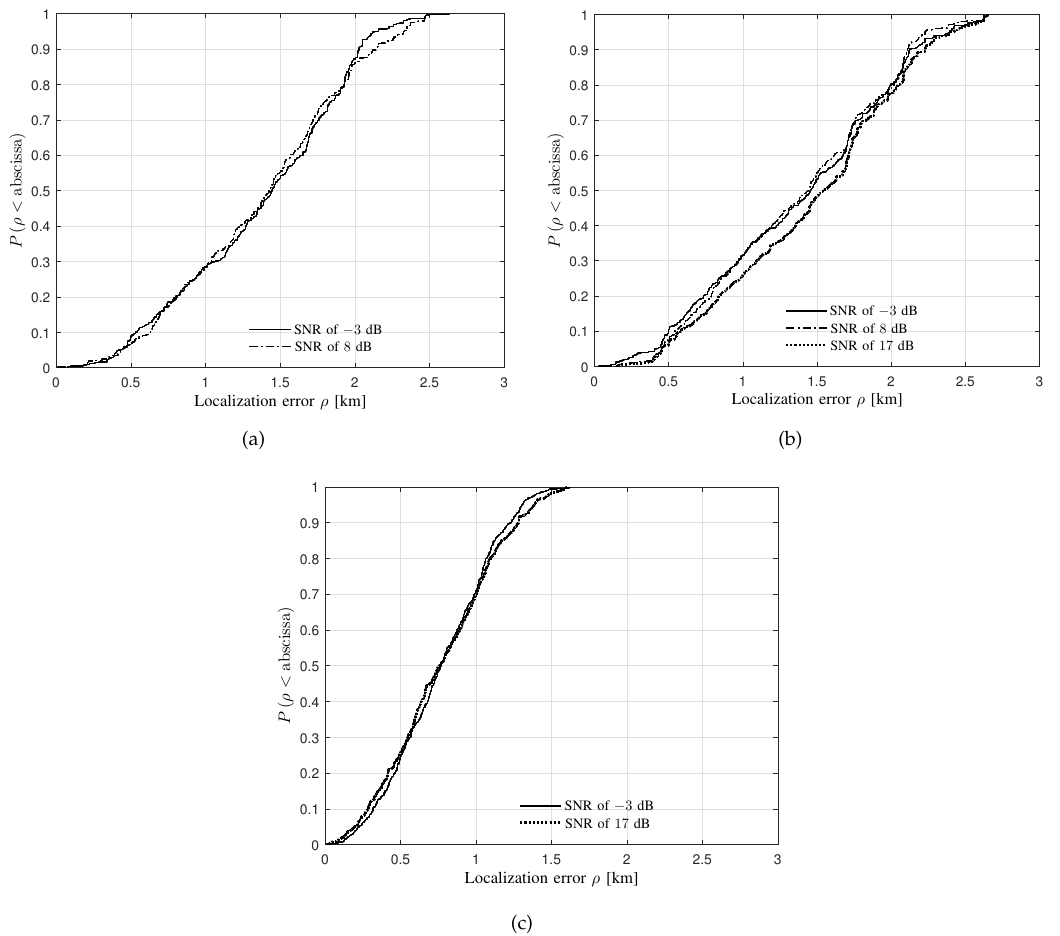
Figure 10. The CDFs of localization error for the NLoS scenario obtained from the verification of the proposed performance-evaluation approach using the commercial localization system. ( a ) BW of 5 KHz; ( b ) BW of 25 KHz; ( c ) BW of 3125